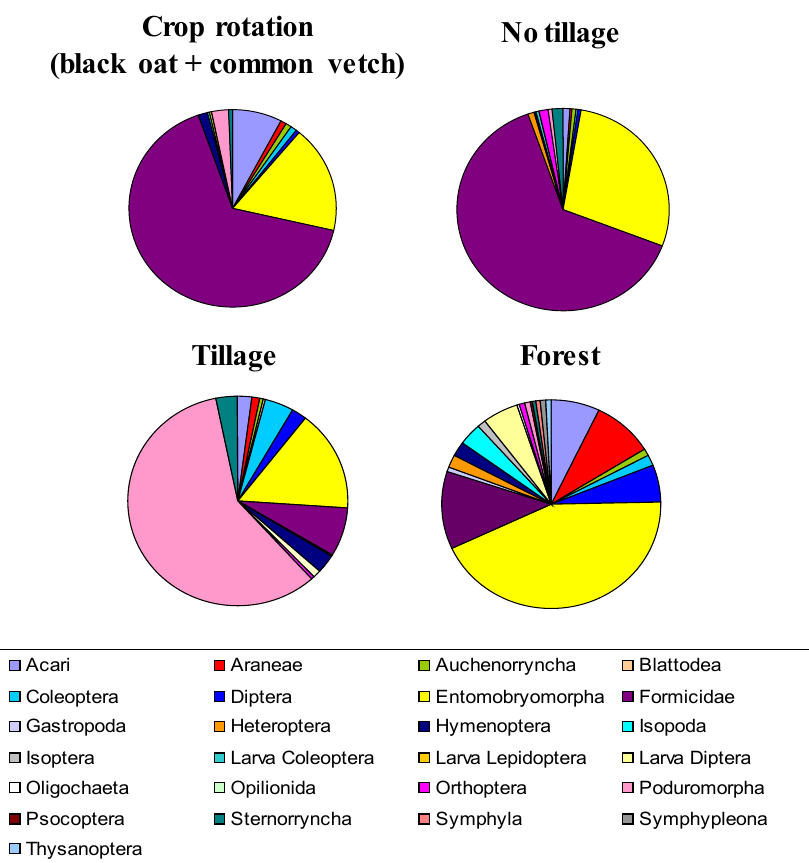
Figure 1. Color graphics discussed with the farmer about soil organism types found in different cultivation successions and in natural vegeta- tion